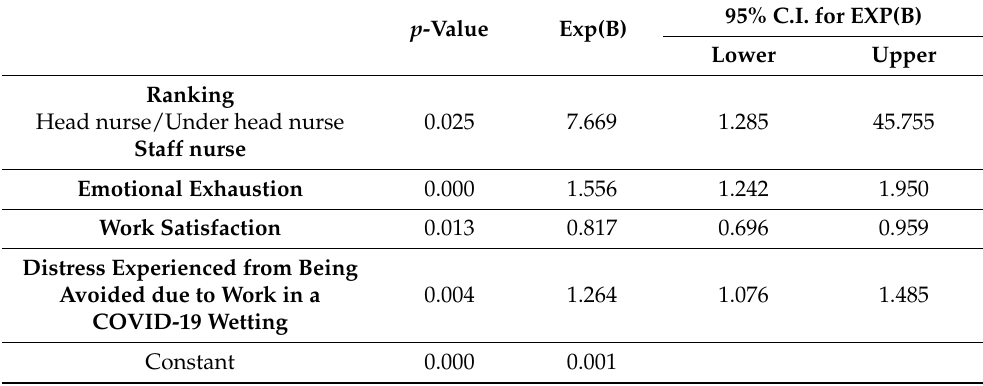
Table 5. The predictors of clinical trauma symptoms (N =